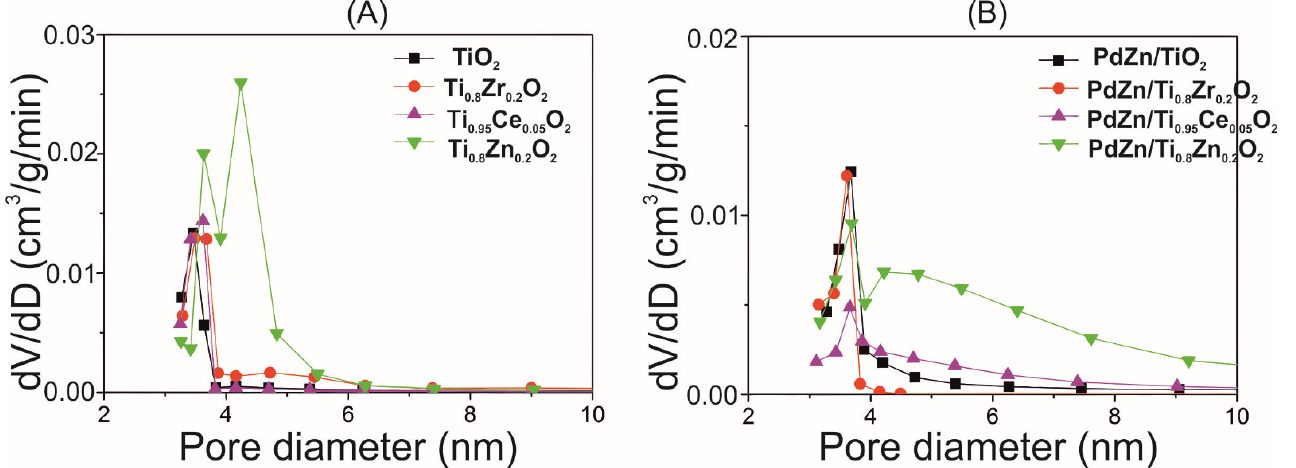
Figure 2. ( A ) Pore size distribution of Ti x M 1-x O 2±y and ( B ) pore size distribution of the powdered catalysts PdZn/Ti x M 1-x O 2±y (M = Ce, Zr, Zn) calcined in vacuum at 13 mbar, 573 K.